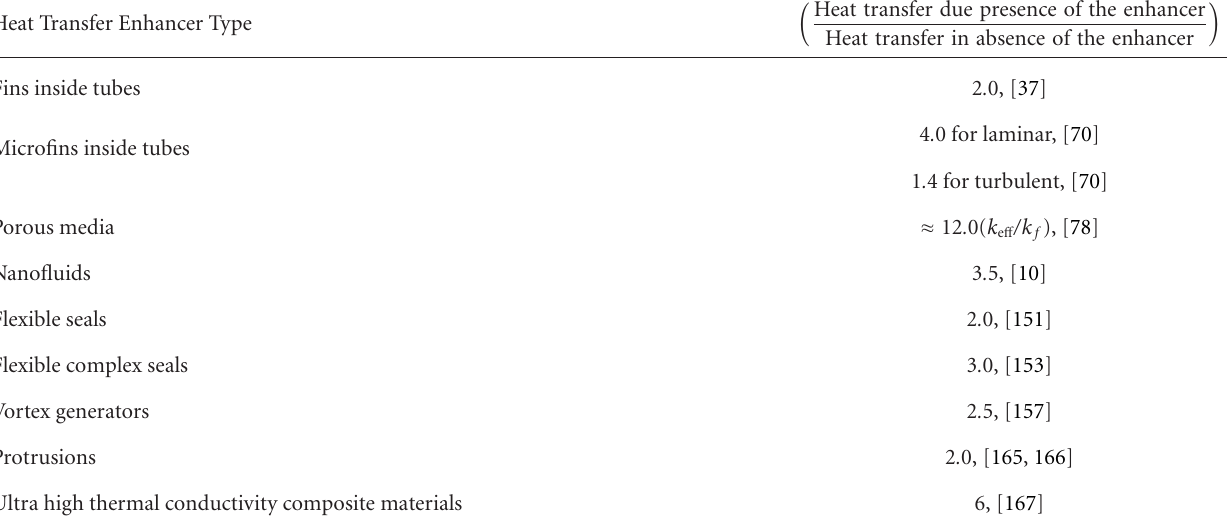
Table 4: Estimated the highest recorded heat transfer enhancement level due to each